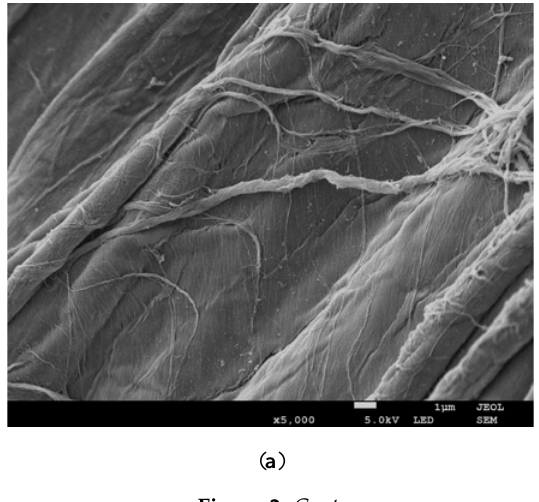
Figure 1. The trickling filters (TF) performance: ( a ) naproxen (1 mg / L) biodegradation: TF-C ( ∆ ), TF-I ( (cid:3) ) and TF-I0 (o); ( b ) removal of the COD in TF-C ( ∆ ), TF-I ( (cid:3) ).Data are presented as the mean ± the standard deviation of three replicates.